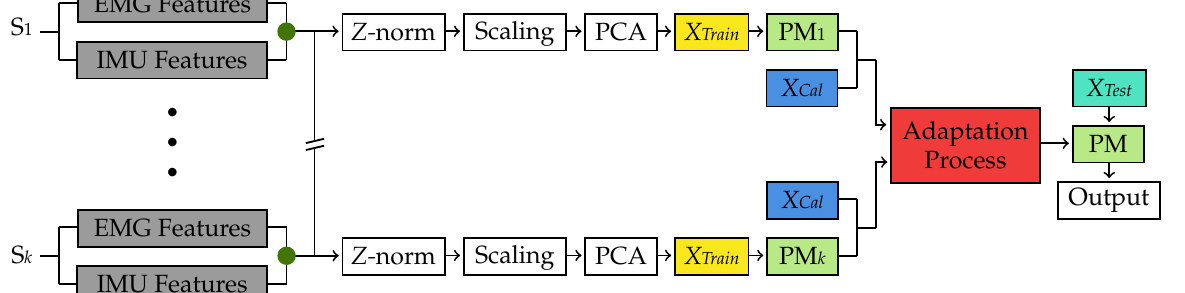
Figure 5. Testing flow for the Adaptive LS-SVM classification method during each cross-validation iteration using both EMG and IMU data. A similar procedure was used for the EMG only dataset. A predictive model (green) is created for each Subject S 1 to Subject S k . Each predictive model is then used to classify X Cal from Subject S n in the iteration training fold and then adapted using the procedure proposed in [8] (red). The adapted predictive model is tested using X Test (aqua) from Subject S n . The green dots represent a feature-level